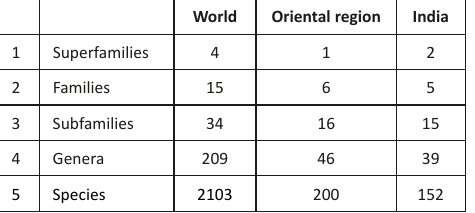
Table 1. Status of the freshwater Ostracoda of the world and India